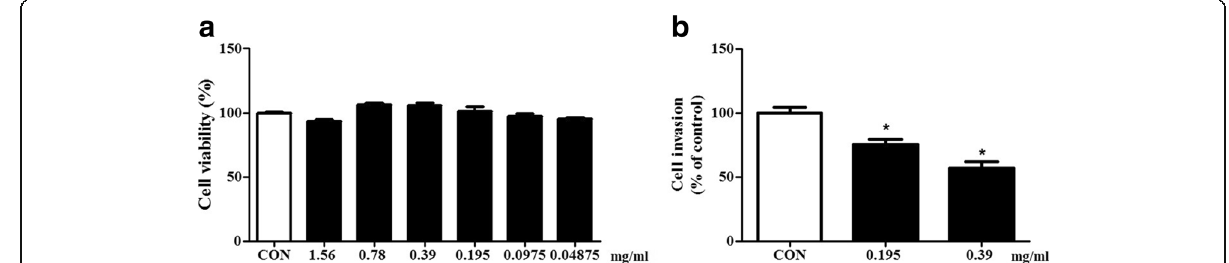
Fig. 4 The effect of Colla corii asini ethanol extract on cell invasion of S. typhimurium . a Colla corii asini ethanol extract did not have an effect on Caco-2 cell viability. b We treated S. typhimurium with various concentrations of Colla corii asini ethanol extract. After 1 h, Caco-2 cells were washed three times with PBS, and gentamicin (100 μ g/ml) was added for 1 h to kill any remaining bacteria. Caco-2 cell lysates were spread on solid agar. After 24 h, we